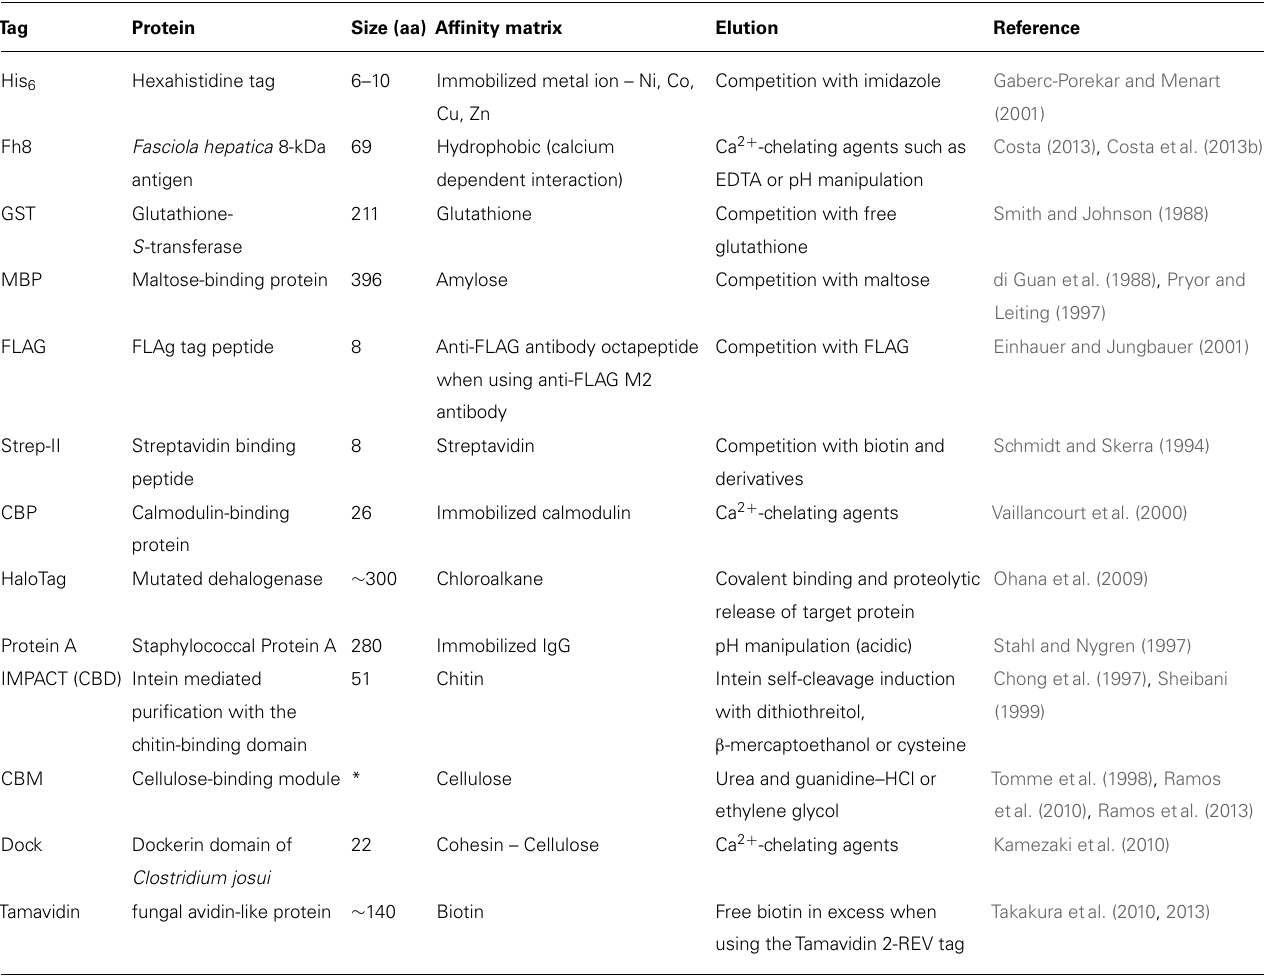
Table 2 |Affinity purification tags [adapted from Esposito and Chatterjee (2006), Malhotra